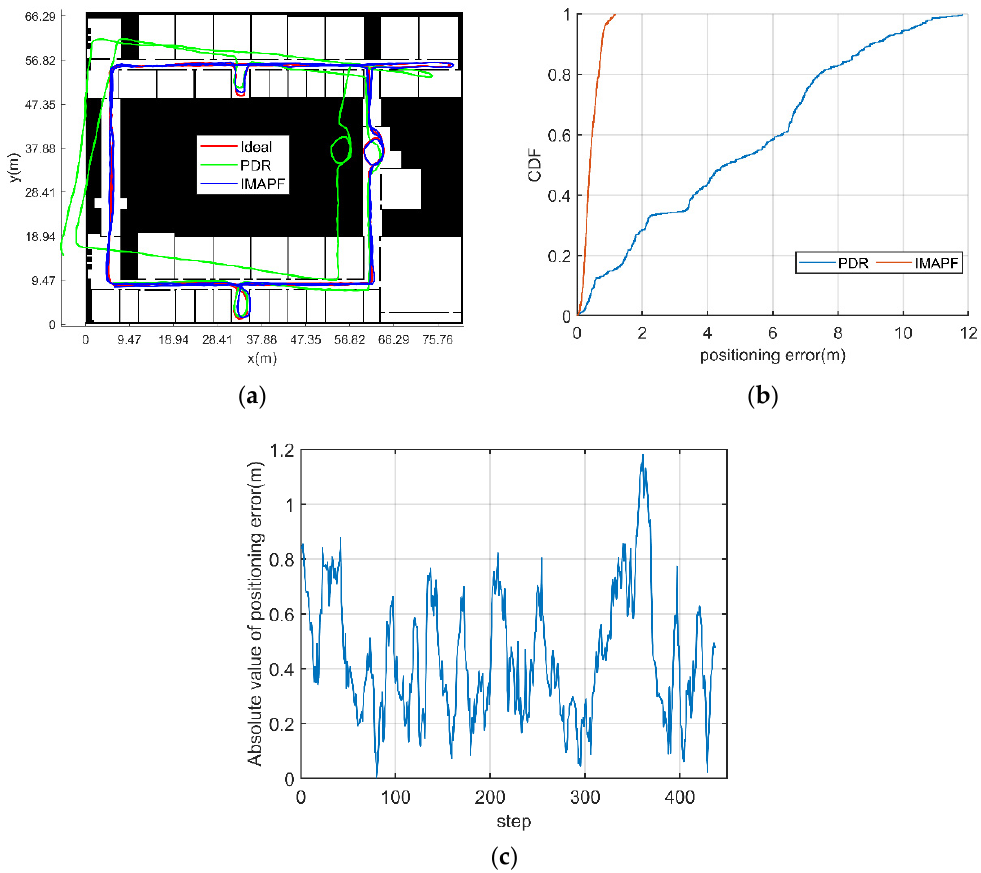
Figure 8. Navigation trace comparison and positioning error CDF curve with known initial position and heading. ( a ) Comparison diagram of positioning trace. ( b ) CDF curve of positioning error. ( c ) Absolute position error of each